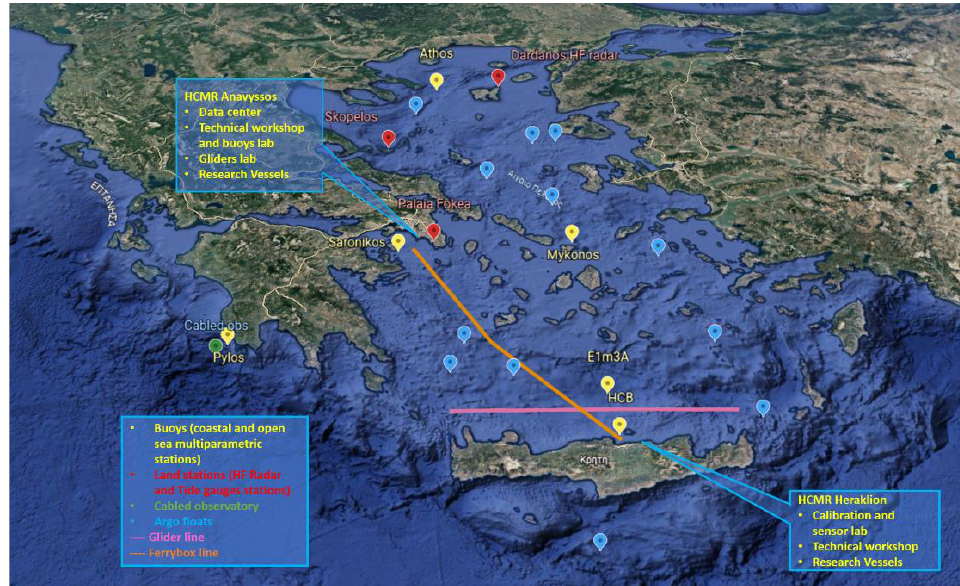
Figure 2. The POSEIDON system operational nodes and shore facilities. The network consists of three coastal platforms operating in marine areas shallower than 300 m (SARONIKOS, HERAKLEION, MYKONOS) and three multiparametric off- shore platforms deployed at ~1500 m (E1M3A, PYLOS, ATHOS). Both coastal and